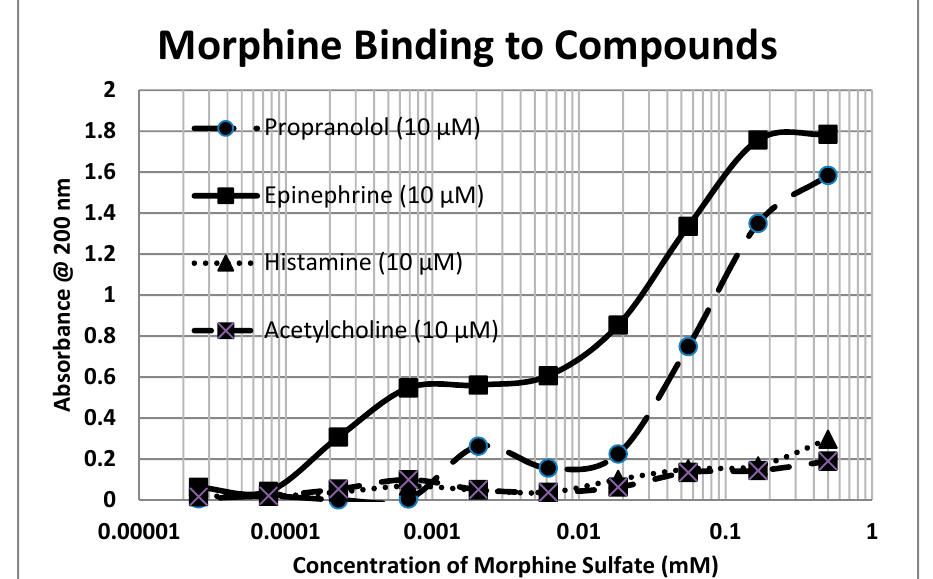
Figure 1. Ultraviolet spectroscopy study of methionine-enkephalin (Met-Enk) binding to various drugs and neurotransmitters. Note that propranolol appears to bind to Met-Enk in a two-phase manner, with high affinity binding around 3 μ M and lower affinity binding around the 35 μ M range. See Table 1 and Figures 2 and 3 for additional data.